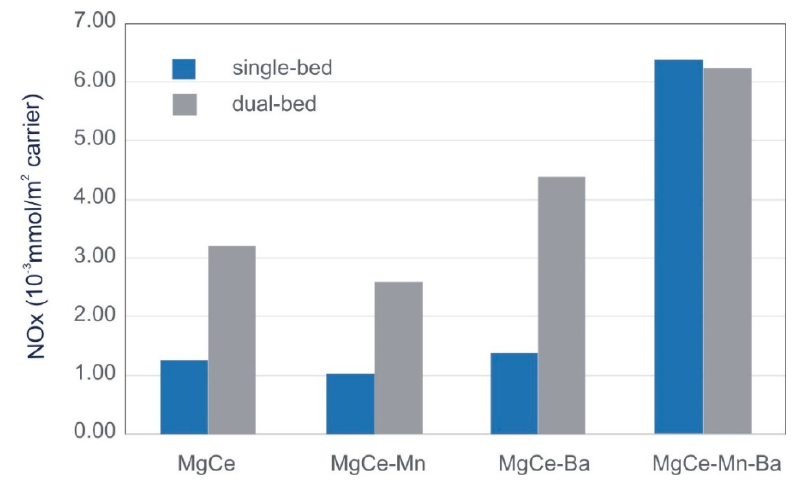
Figure 3. Stored amounts of NO x observed in single-bed and dual-bed experiments.